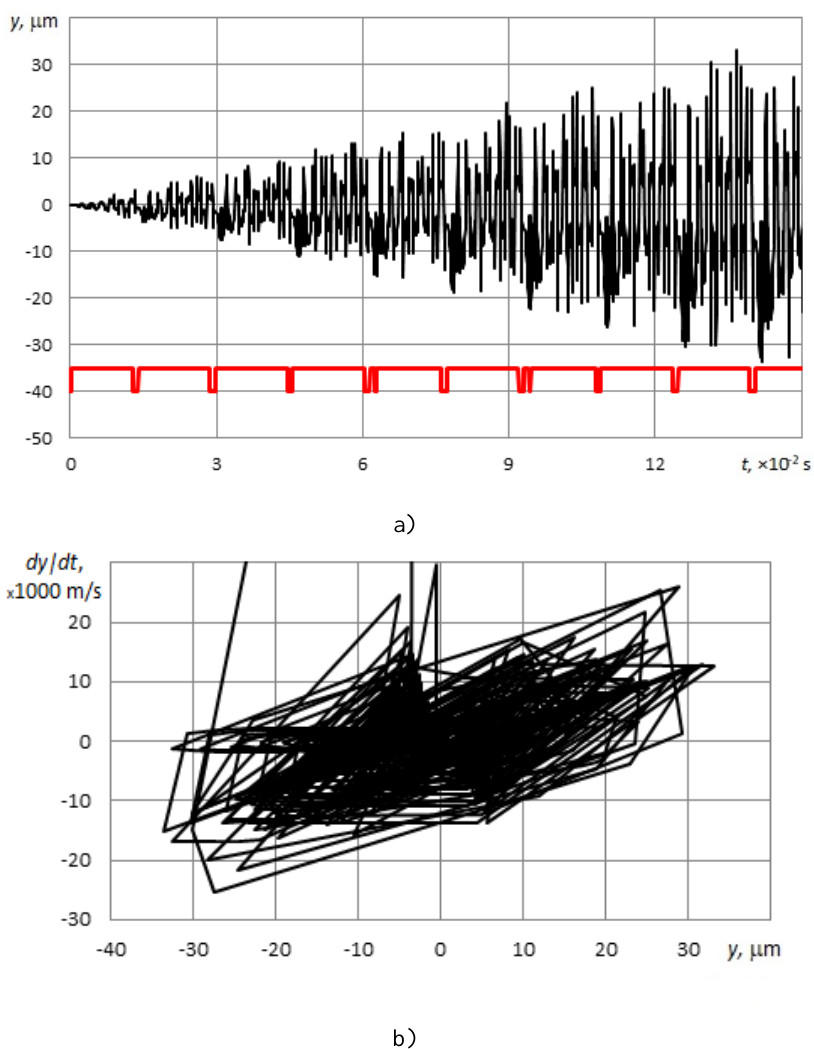
Figure 5. Calculated vibratory displacements at V=60 m/min (a) and phase-plane portrait